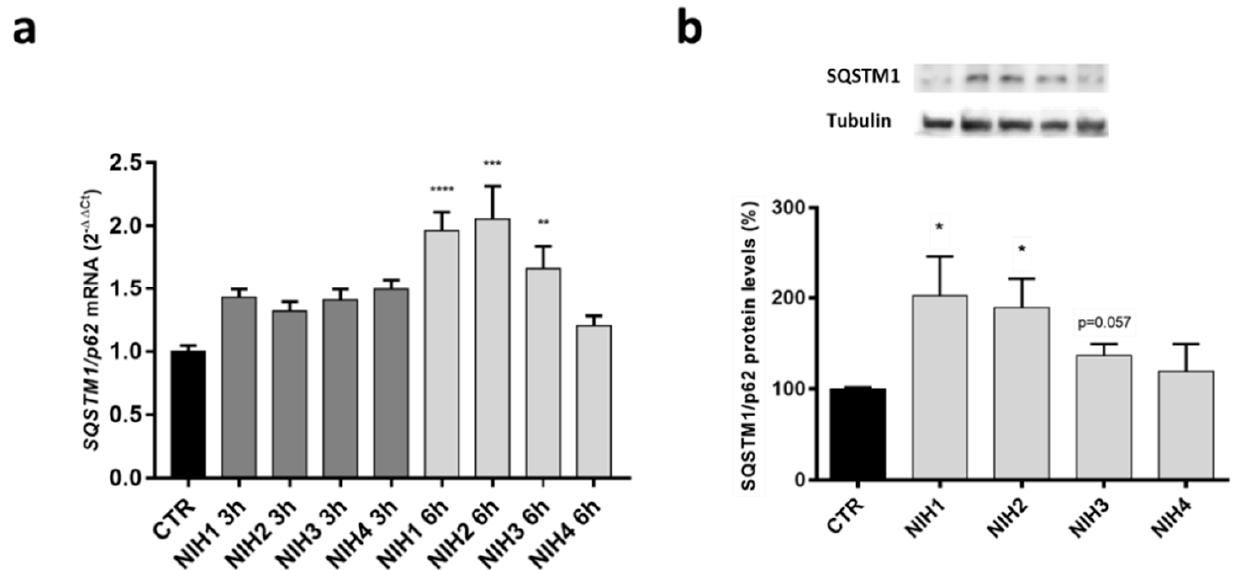
Figure 4. The effect of NIH compounds on the mRNA and protein expression of SQSTM1/p62. ARPE-19 cells were treated with 5 µM of NIH compounds for 3 h or 6 h. ( a ) The expression levels of SQSTM1/p62 were measured with quantitative PCR after 3 h and 6 h treatment periods. The data were normalized against housekeeping gene GAPDH, and the results are shown as fold change compared to control ± S.E.M. n = 4. ** p < 0.01, *** p < 0.0005, **** p ≤ 0.0001, Dunn’s multiple comparisons test. ( b ) The protein levels of SQSTM1/p62 after NIH treatments for 6 h. The data were normalized against α -Tubulin (representative Western blotting gels are reported), and the results are shown as comparison to the control (CTR, 100%) ± S.E.M. n = 4. * p < 0.05, Dunn’s multiple